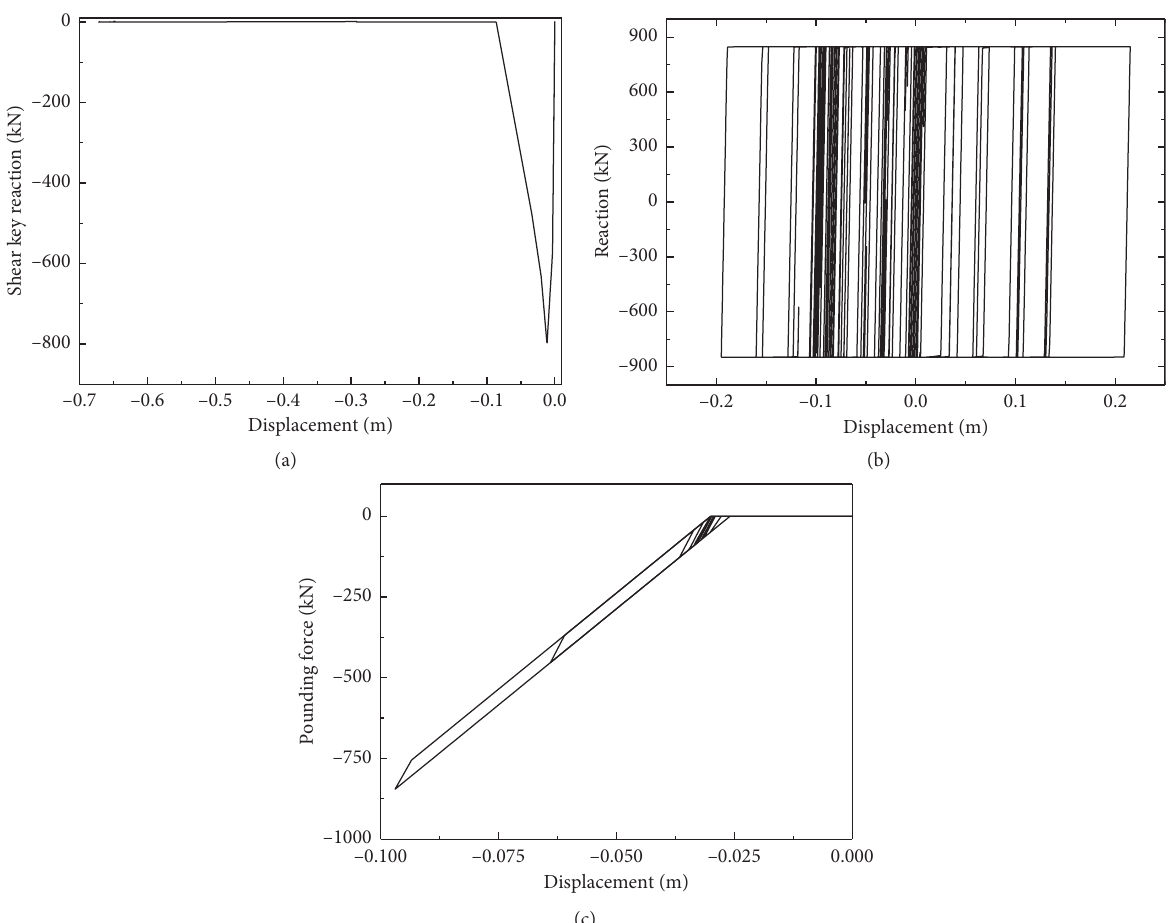
Figure 11: Force-displacement responses of various nonlinear elements of continuous beam-arch bridge under Landers earthquake motions: (a) shear key of abutment; (b) bearing; (c) pounding.